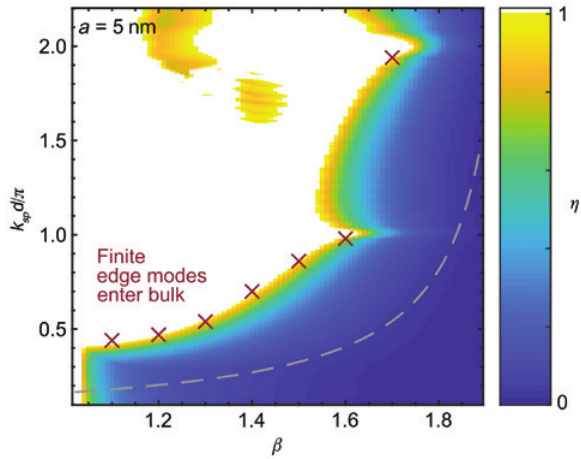
Figure 6: η for the transverse modes of the chain, for different β and k d , which saturate so that values of η > 1 are white. sp The red crosses correspond to the locations where edge modes enter the bulk in finite 600 particle chains, possibly indicating the BEC breakdown. The grey dashed line corresponds to the minimum d / π for which the CDA is a good value of k sp